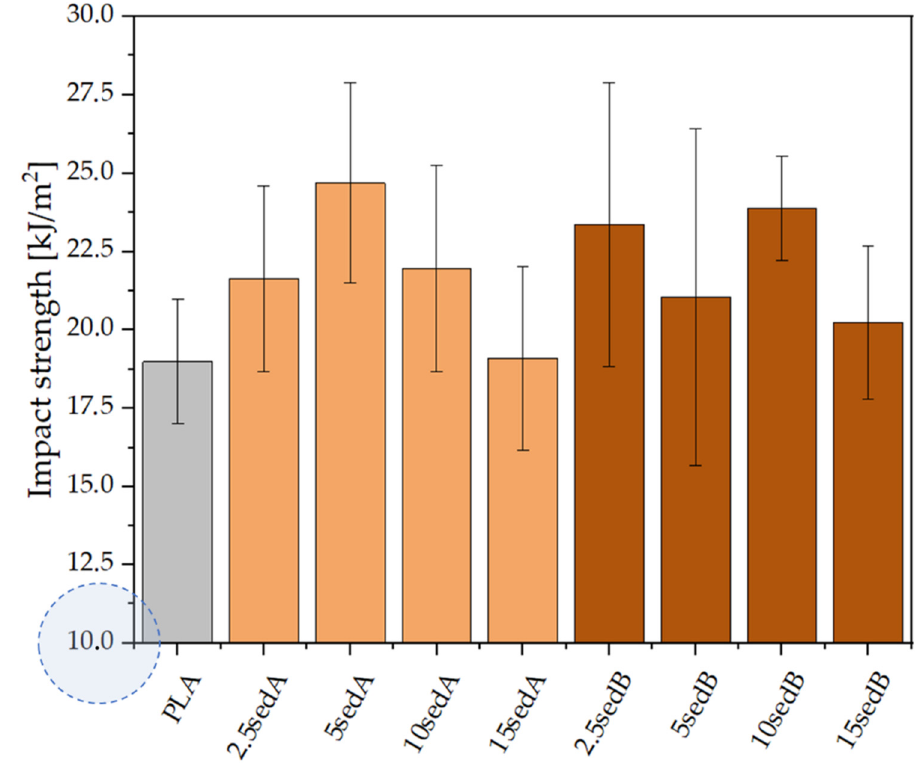
Figure 11. Impact strength of the PLA/sedA-B composites.